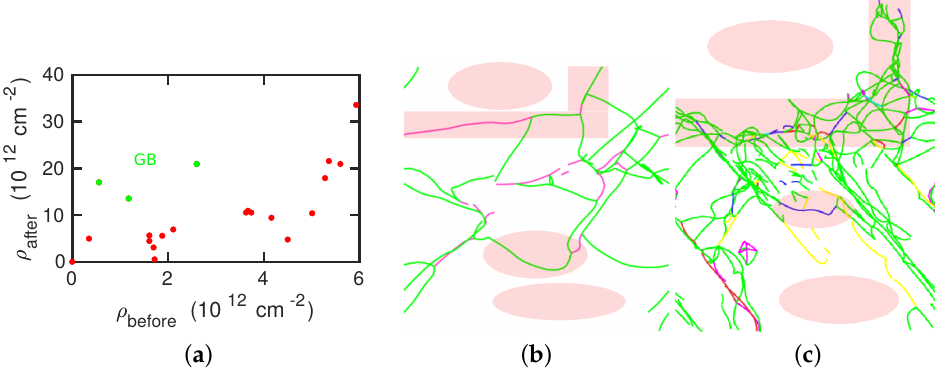
Figure 10. ( a ): Comparison of the dislocation density before and after the austenitic phase transition. Green data points marked by ‘GB’ denote cases of abundant dislocation production organized in grain boundaries; ( b , c ) snapshots of a specimen with a dislocation density of 3.63 × 10 12 cm − 2 before ( b ) and after ( c ) the transformation. The colors denote the dislocation type as in Figure 1. Pink areas highlight corresponding regions before and after the